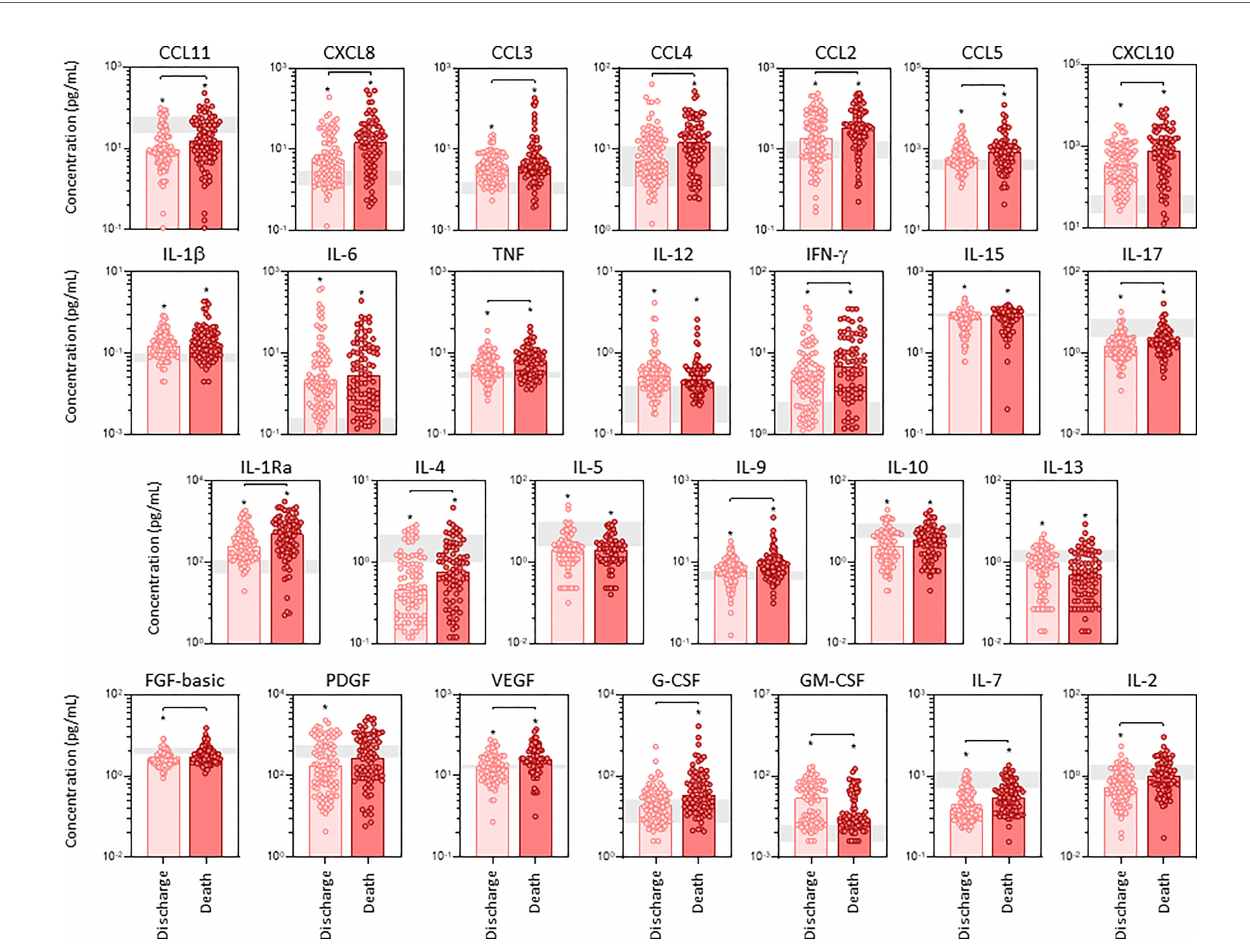
FIGURE 2 | Panoramic overview of serum soluble immune mediators in critically ill COVID-19 patients at ICU admission, according to disease outcome. The concentration of chemokines (CXCL8, CCL11, CCL3, CCL4, CCL2, CCL5, CXCL10), pro-in fl ammatory cytokines (IL-1 b , IL-6, TNF, IL-12, IFN- g , IL-15, IL-17), regulatory cytokines (IL-1Ra, IL-4, IL-5, IL-9, IL-10, IL-13) and growth factors (FGF-basic, PDGF, VEGF, G-CSF, GM-CSF, IL-7 and IL-2) were quanti fi ed in serum samples from critically ill COVID-19 patients – “ COVID ” (n = 183) at ICU admission (D0=baseline), further categorized according to disease outcome, referred as “ Discharge ” ( ● , n = 97) or “ Death ” ( ● , n = 86). The gray zone represents the reference interquartile range (25 th -75 th ) observed for pre-pandemic healthy controls “ HC ” (n = 135). Measurements were carried by high-throughput microbeads array as described in Material and Methods section. The results are expressed in pg/mL and presented as scattering distribution of individual values over bar plots underscoring the median value on each bar. Signi fi cant differences at p < 0.05 are indicated by asterisk (*) as compared to HC and by connecting lines for comparisons between Discharge versus